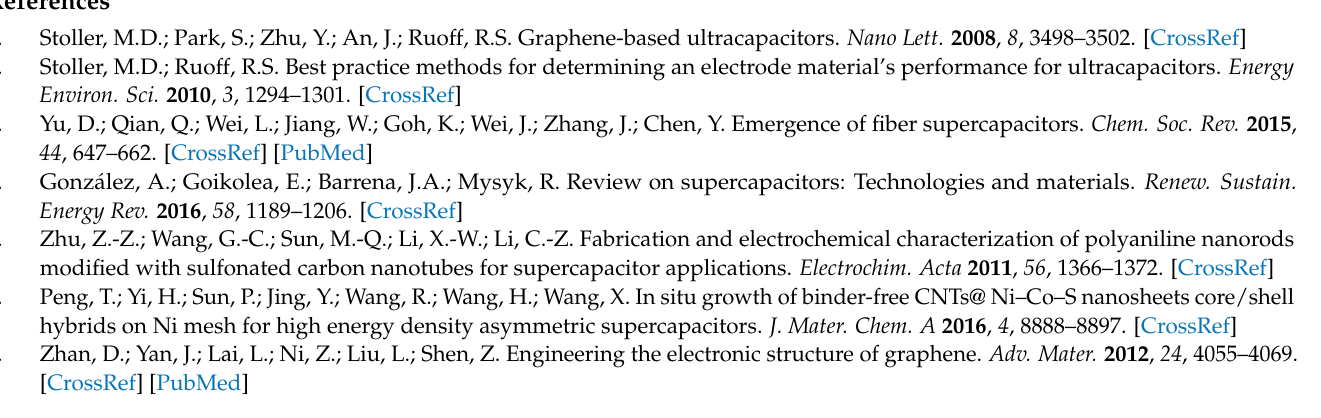
Figure 7. ( a ) Impedance phase angle versus frequency plot of the AG/rGO/P-Cu mesh electrode. ( b ) Cycling stability test of the AG/rGO/P-Cu mesh supercapacitor at a current density of 4 A/g for 2000 cycles.